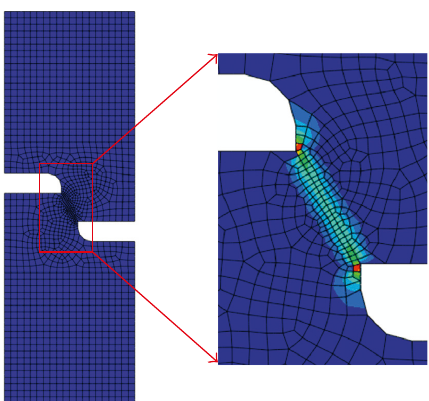
Figure 14: The distribution of equivalent plastic strain at the fracture time step in a typical numerical simulation.